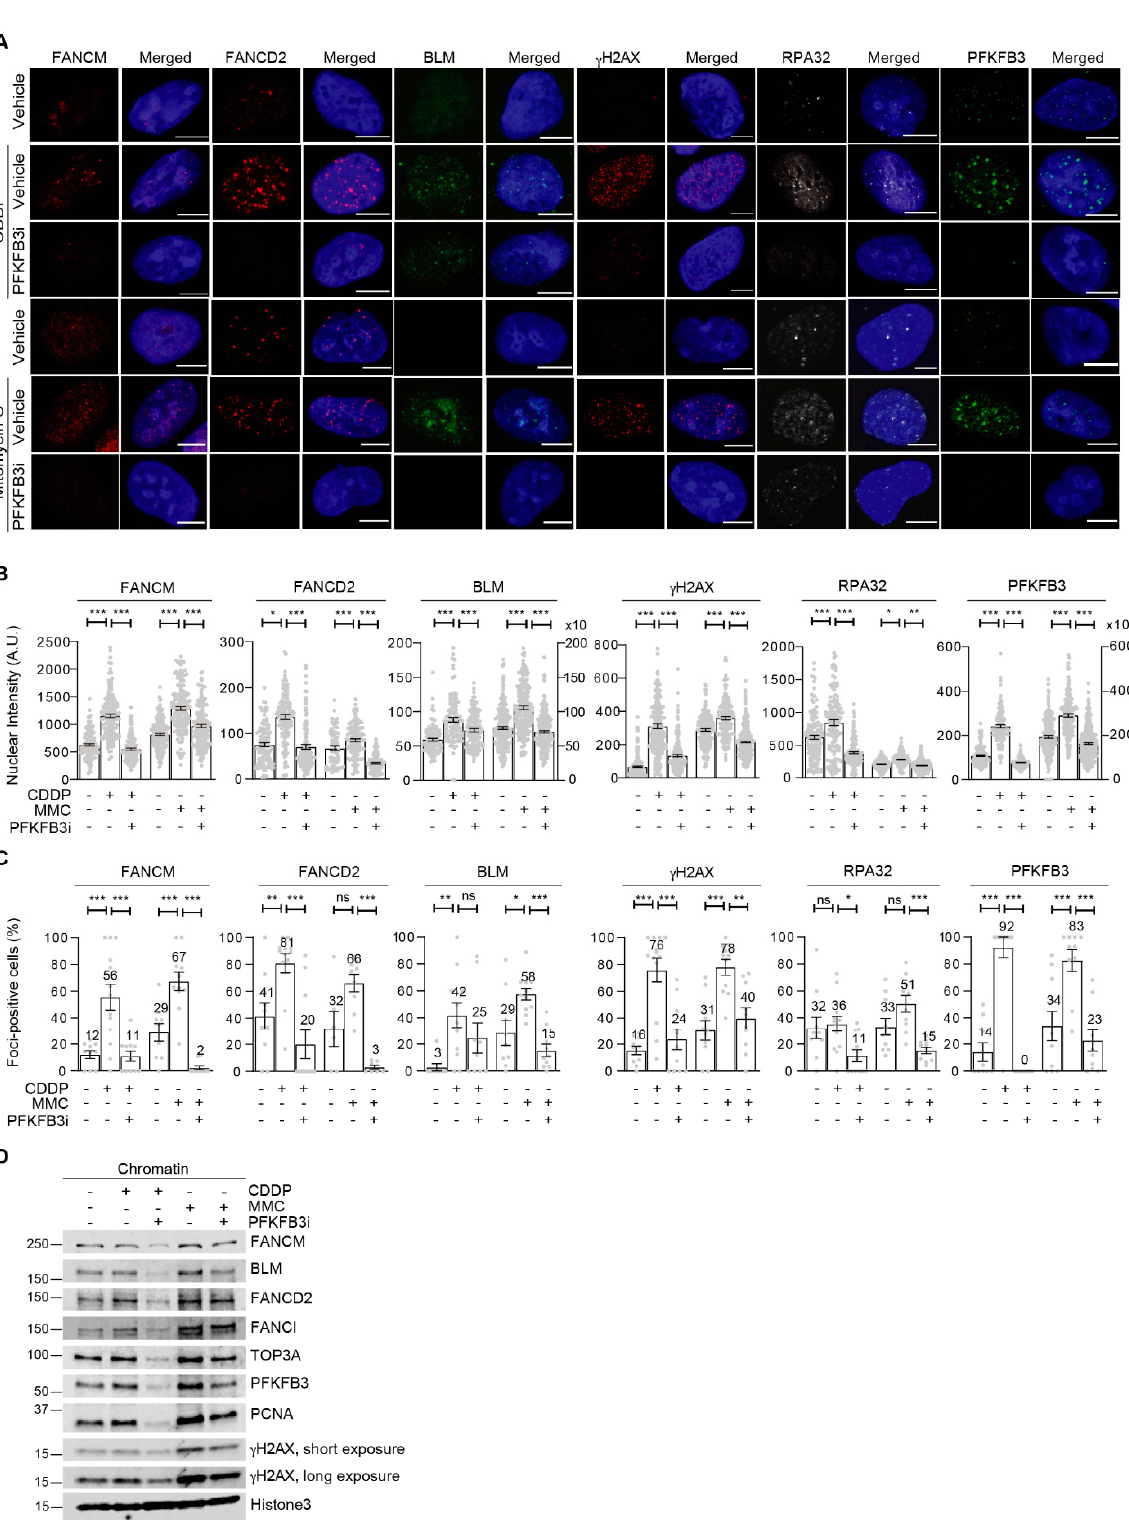
Figure 4. PFKFB3 kinase activity promotes recruitment of FA factors into foci. ( A ) Representative confocal images of nuclear foci of FA-associated factors FANCM, FANCD2, and BLM helicase, DNA damage surrogate marker γ H2AX and RPA32 as well as PFKFB3, in synchronized U2OS cells exposed for 3 h to cisplatin (CDDP, 20 µ M), Mitomycin C (MMC, 360 nM) and PFKFB3i (10 µ M), or left untreated, n ≥ 2 independent experiments. Scale bar, 10 µ m. ( B ) Quantification of FANCM, FANCD2, BLM, γ H2AX, and PFKFB3 nuclear integrated intensity from ( A ). Quantification performed with Cell- Profiler. Data displayed as scatter dot plot with means ± S.E.M, one data point represents one cell, n ≥ 2 independent